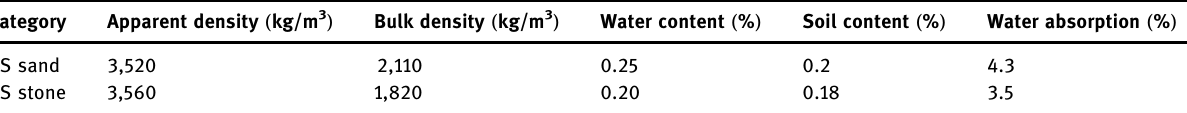
Table 4: Physical properties of SSA